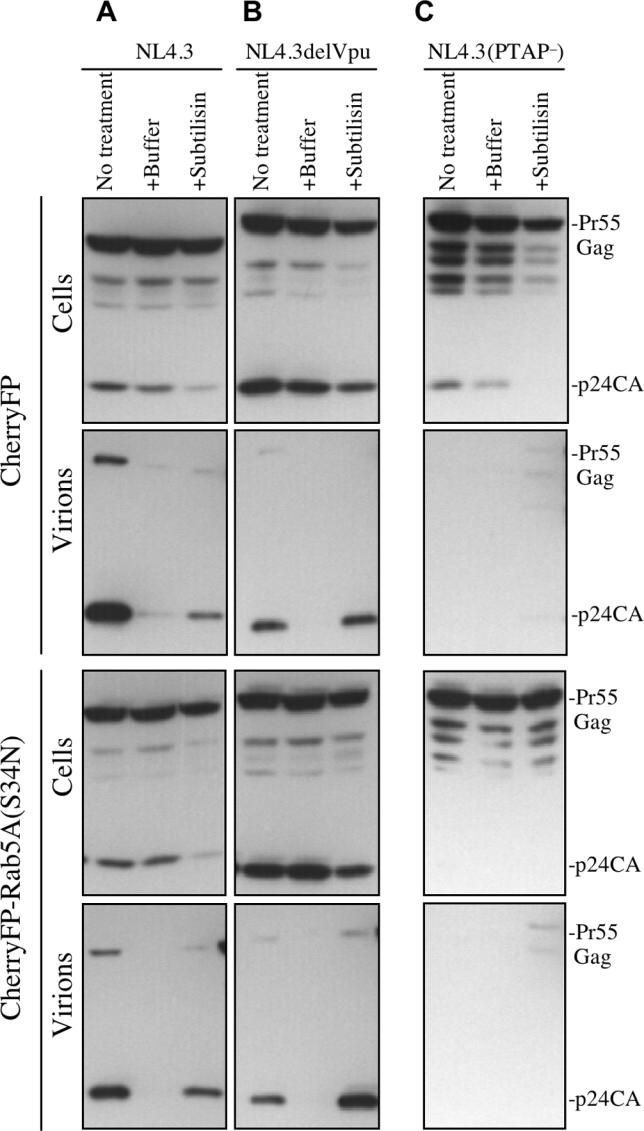
Absence of Vpu Results in Cell-Surface Entrapment of Mature VirionsSubtilisin-induced release of mature, Vpu-defective HIV-1 particles from HeLa cells. Hela cells were transfected with NL4.3 (A), NL4.3delVpu (B), or NL4.3 (PTAP−) (C) proviral plasmids as indicated, in the presence of CherryFP-Rab5a(S34N) or CherryFP-expression vectors. Cells and supernatants were harvested 48 h post-transfection and analyzed directly (no treatment), while cells in replicate wells were either treated with 1 mg/ml subtilisin (+ subtilisin) or a buffer control (+ buffer) for 15 min at 37 °C. Virions released by buffer or subtilisin and corresponding cell lysates were harvested and analyzed by Western blotting with an anti p24CA antibody as before.